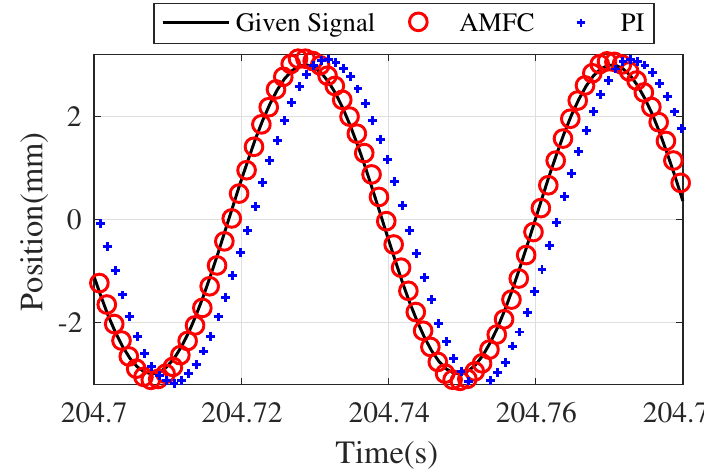
Figure 29. Position output of PMLOSM of PI and AMFC.